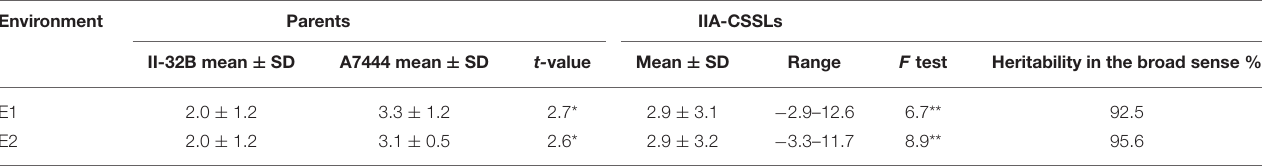
TABLE 1 | Phenotypic values of the PEL of parents and IIA-CSSLs across two environments.